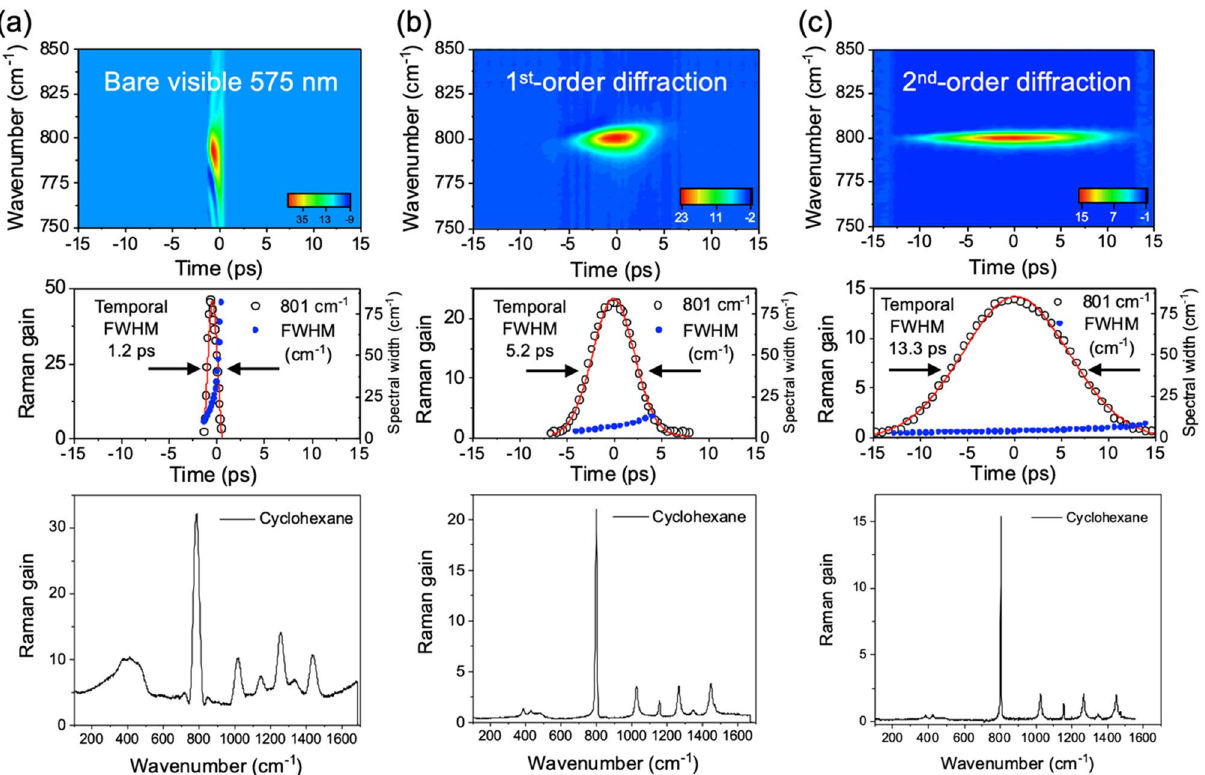
Figure 3. (Top) Two dimensional cross-correlation measurements of the stimulated Raman band at 801 cm −1 of cyclohexane using the 575 nm ps Raman-pump pulse and the fs broad Stokes Raman-probe pulse. Three different Raman-pump pulse of ( a ) the bare output from the ps-OPA, ( b ) the SHG output from the 1st-order diffraction DPGF, and ( c ) the SHG output from the 2nd-order diffraction DPGF are shown. The power of Raman-pump pulse was ~ 700 nJ/pulse in all three experimental condition. (Middle) Temporal cross-correlated FWHMs (the opened black circle) of the 801 cm −1 Raman gain of cyclohexane at the slit width of 0.15 mm. Spectral FWHMs (the filled blue circle) of the 801 cm −1 Raman band as a function of the delay-time.